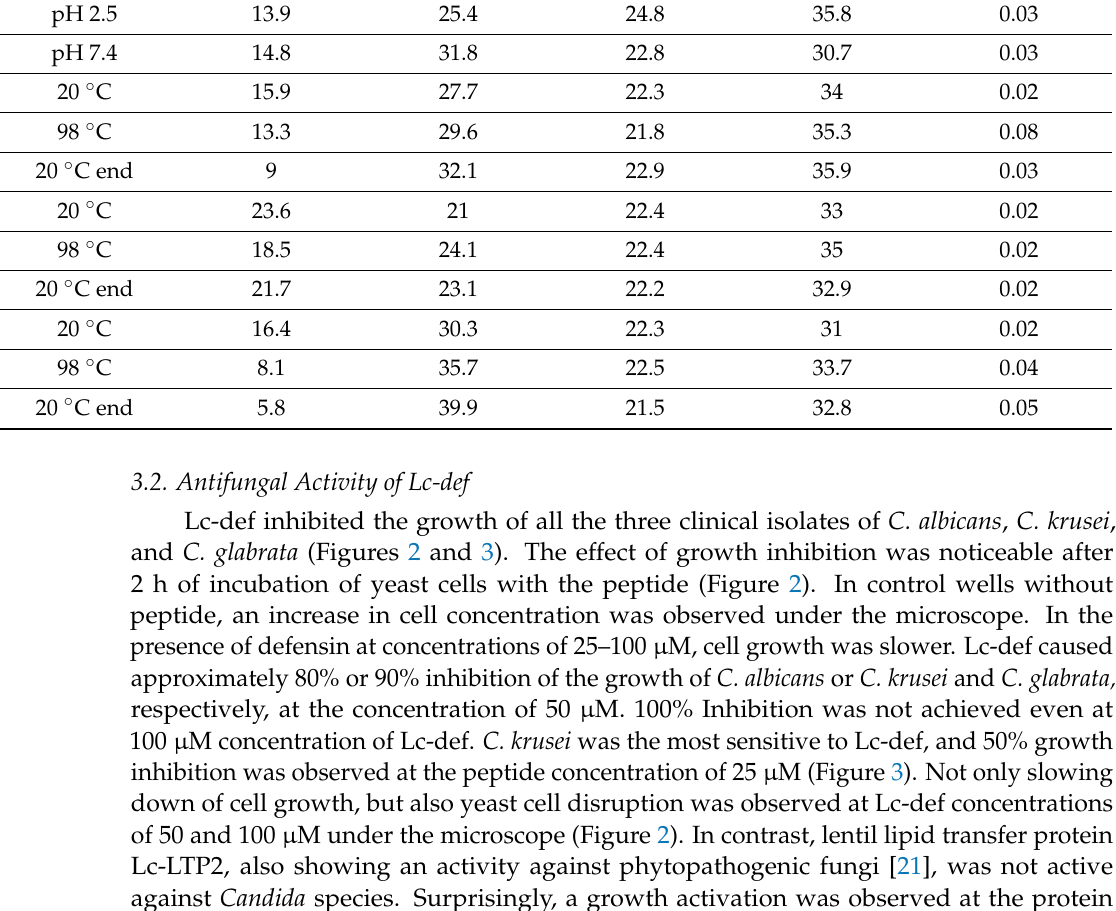
Figure 3. Antifungal activity of Lc-def at different concentrations (100, 50, 25, 12.5, 6.25, 3.125, and 1.56 μ M) against the clinical isolates of C. albicans , C. krusei , and C. glabrata after incubation during 24 h. Error bars represent a standard deviation between two replications. A significant difference ( **, p < 0.01) was observed for all the three Candida species for Ls-def at concentrations of 50 and 100 μ M. 3.3. Hemolytic and Cytotoxicity Assays of Lc-def Lc-def did not cause hemolysis of erythrocytes even at the concentration of 100 μ M. At the same time, 50% hemolysis was observed for the membranotropic peptide melittin at the concentration of 1.6 μ M (Supporting Materials, Figure S3B). Lc-def was not toxic to PBMCs. Cell viability of 100% was observed even at the peptide concentration of 50 μ M. At the same time, the death of about 50% of cells was observed for melittin at the concen- tration of 6.25 μ M (data not shown). 3.4. Resistance of Lc-def to Proteolysis At first, a sensitivity of Lc-def to proteolysis by C. albicans was studied using the yeast sample with a high concentration (10 9 cells/mL). In electropherograms of both samples with pH of 4.0 or 7.2, the major protein of C. albicans with the molecular mass of approxi- mately 60 kDa was observed. α -Casein used as a model protein was highly susceptible to